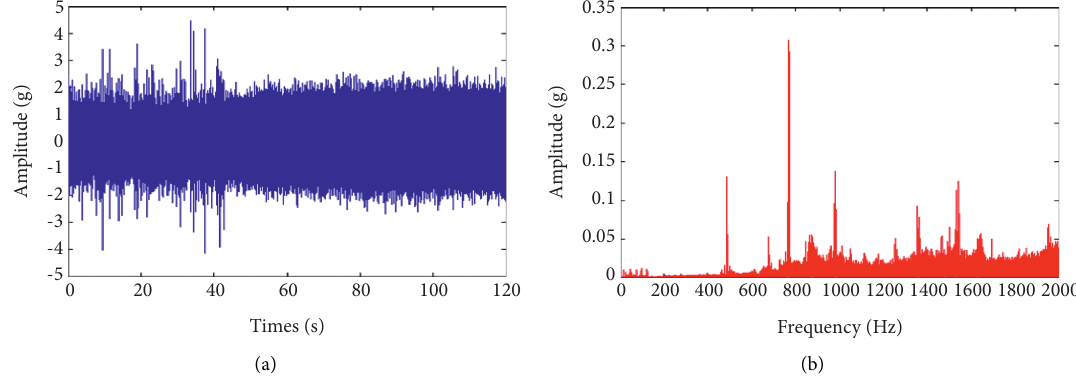
Figure 15: Experimental acceleration values at measuring point 2. (a) Experimental results for time domain acceleration at measuring point 2. (b) Experimental results for frequency domain acceleration at measuring point 2.